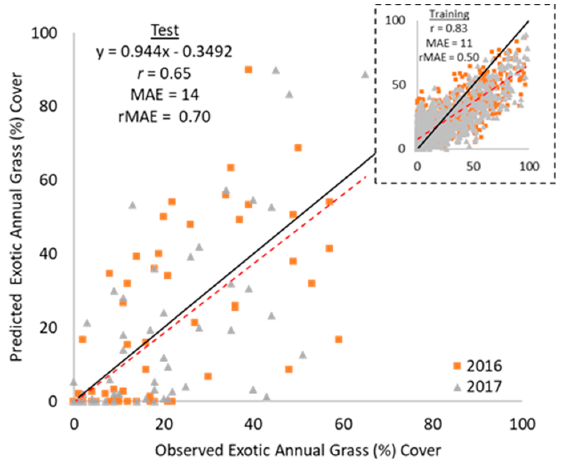
Figure 6. Predicted versus observed exotic annual grass cover (%) from independent test ( n = 112) and model training data ( n = 1700) collected during 2016 and 2017. Pearson’s correlation coefficient ( r ), mean absolute error (MAE), and relative MAE (rMAE) are calculated using all data points. Both years of data were fit using ordinary least-squares regression (dashed red line) and the 1:1 line is shown as a solid black line.